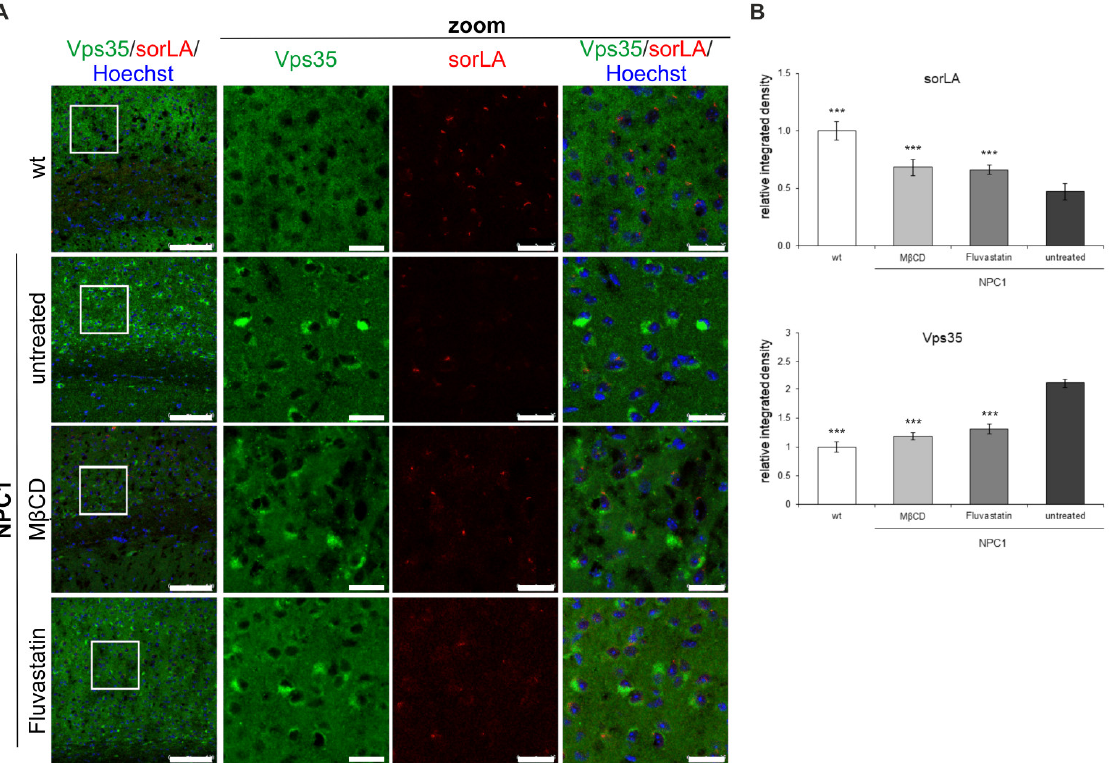
Figure 10. SorLA and Vps35 distribution in the cortex of 10-week old NPC1 mice is rescued by cholesterol depletion in vivo. NPC1 mice were treated with cholesterol-lowering therapy, MβCD or statin (fluvastatin). ( A ) Immunostaining of Vps35 (green) and sorLA (red) was analyzed by confocal microscopy. ( B ) Fluorescent signals (integrated density) were quantified using ImageJ software and compared to untreated NPC1-mice (*** p < 0.001). The data are shown as mean ± SD normalized to control and represent data from three different experiments, n = 9 slices per animal, 6 animals per group. Scale bar—100 µ m (unzoomed pictures) and 20 µ m (zoomed